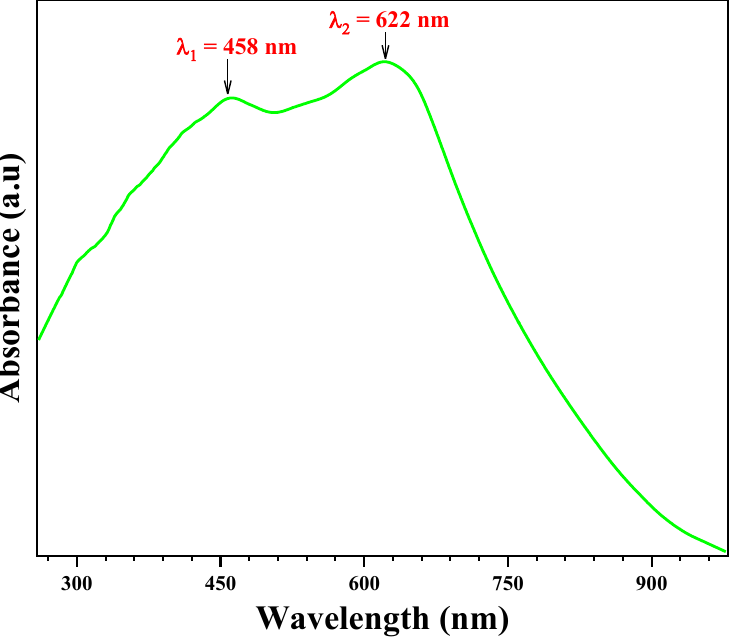
Figure 5. UV-visible absorbance spectra of Se NPs. Figure 6 indicates the relation between the optical absorption coefficient and the wavelength of Se NPs prepared by the green method. The results confirm that the sample